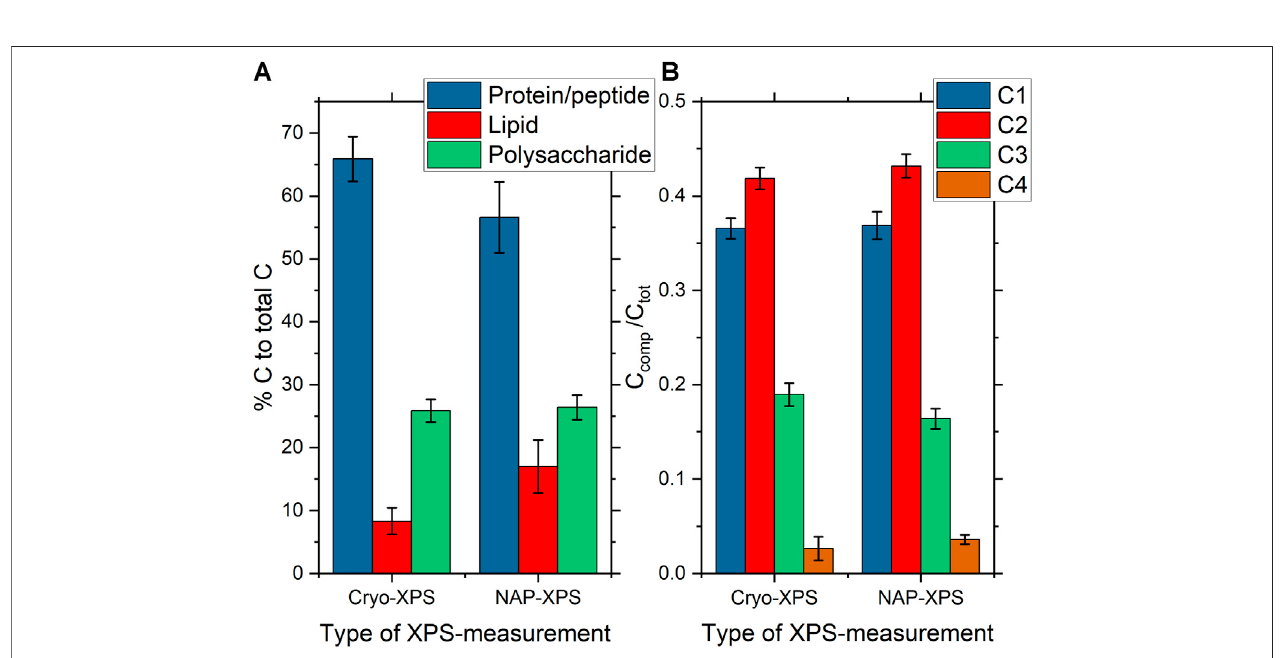
FIGURE 5 | (A) Bar charts showing the average surface composition of P. fl uorescens samples expressed as the amount of substance related to the different molecular classes constituting the bacterial cell-envelope measured under cryo-conditions (n (cid:2) 9) and NAP-conditions (n (cid:2) 6) as obtained by analysis of the respective C1s spectra using the Umeå method. Error bars represent the standard deviation. The percentage on the y-axis gives the predicted carbon atom percentages for the differentmolecularclassesintherespectiveC1sspectra. (B) BarchartsshowingtheaverageC1scomponentpeakintensitiesof P. fl uorescens samplesmeasured under cryo-conditions (n (cid:2) 9) and NAP-conditions (n (cid:2) 6) as obtained by analysis of the respective C1s spectra using peak fi tting analysis ofhigh resolution C1s with the CasaXPS software for cryo-XPS data and Uni fi t for NAP-XPS data. C1s component peaks are assigned in the caption to Figure 4 .